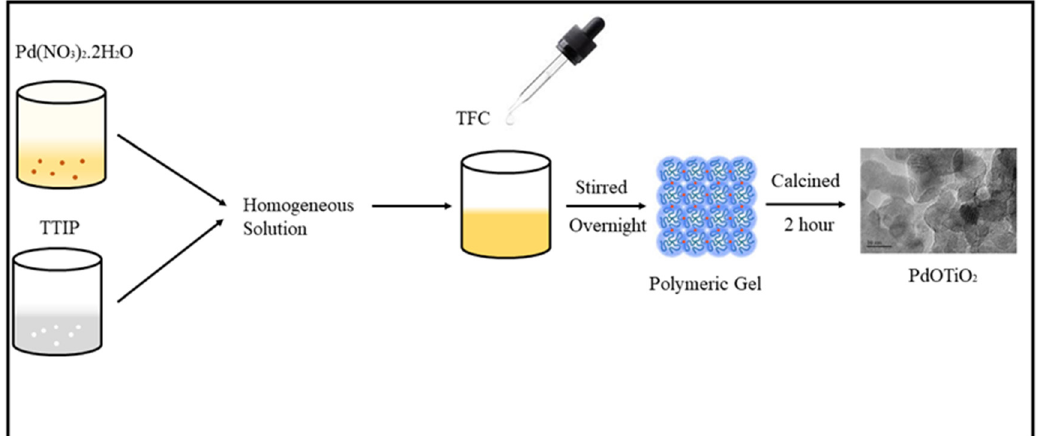
Figure 7. Schematic diagram for synthesis of catalyst